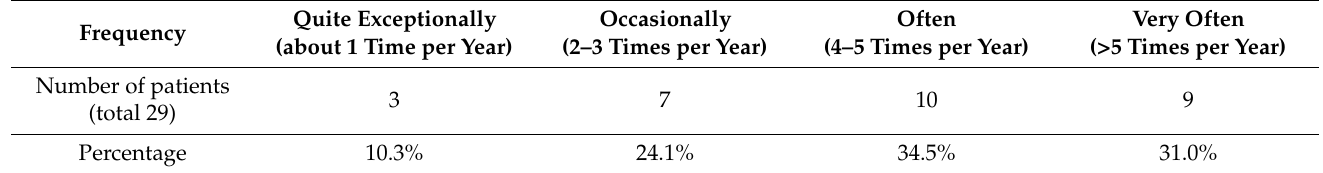
Table 4. Distribution of the frequency of the cold sores per patient per